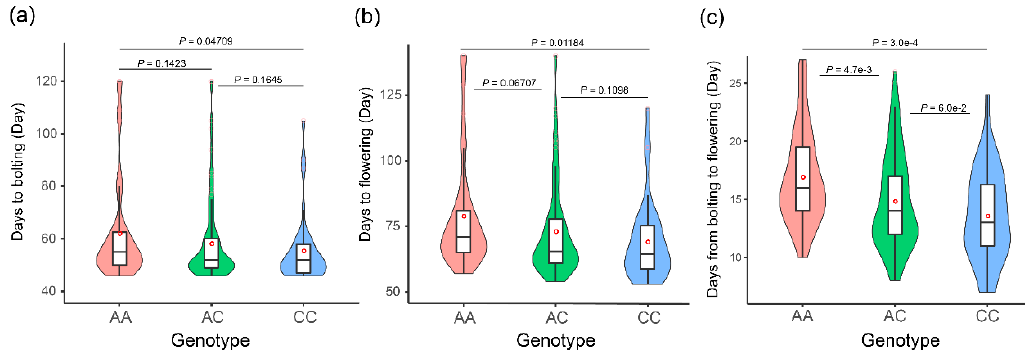
Figure 5. Distribution of bolting time ( a ), flowering time ( b ), and time from bolting to flowering ( c ) in an F 2 population. AA, homozygous A allele of BrFLC1Pe1+58; CC, homozygous C allele of BrFLC1Pe1+58; AC, heterozygous for BrFLC1Pe1+58. Comparisons are done by Student ‐ Newman ‐ Keuls test with α = 0.01.